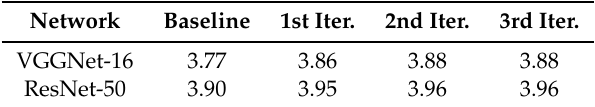
Figure 4. Selected samples, including both good cases ( a ) and failure cases ( b ). For each case, the query is on the left, and top-3 returned results are on the right. The images in the first row of each case are the results of the original pre-trained model, and in the second row are the results of the fine-tuned model. True positives and false positives are marked with green and red circles on the lower-left corner of each result image, respectively. Table 3. Demonstration of the effectiveness of the iteratively mining and training process on UKBench. Networks are fine-tuned for three iterations, and the performance is evaluated with a N-S